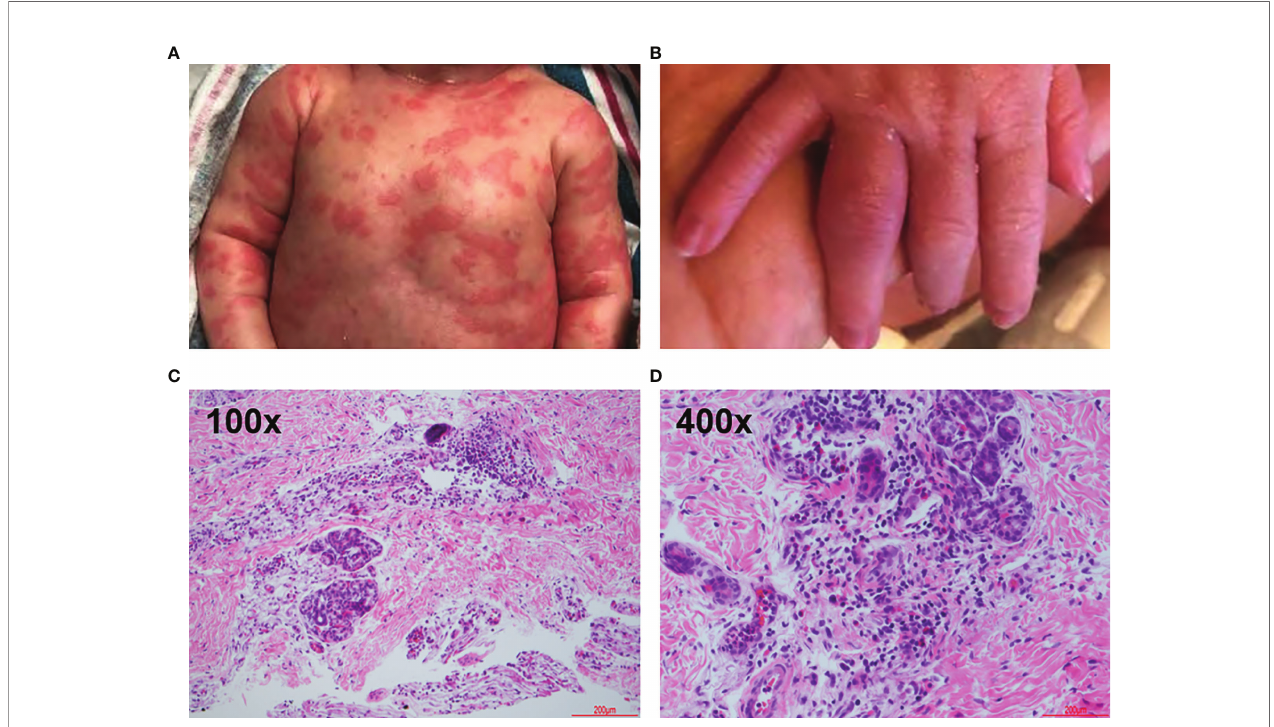
FIGURE 1 | Clinical and Representative Histologic Findings. Infant at approximately 1 week of age. (A) Skin eruption on the ventral torso. (B) 4 th proximal interphalangeal joint arthritis. (C, D) Hematoxylin-eosin stains showing mixed dermal in fl ammation with numerous eosinophils. Skin, left leg biopsy. Step level sections with unremarkable dermis. Papillary dermal edema and a dense perivascular, periadnexal and interstitial in fi ltrate of lymphocytes and numerous eosinophils. No